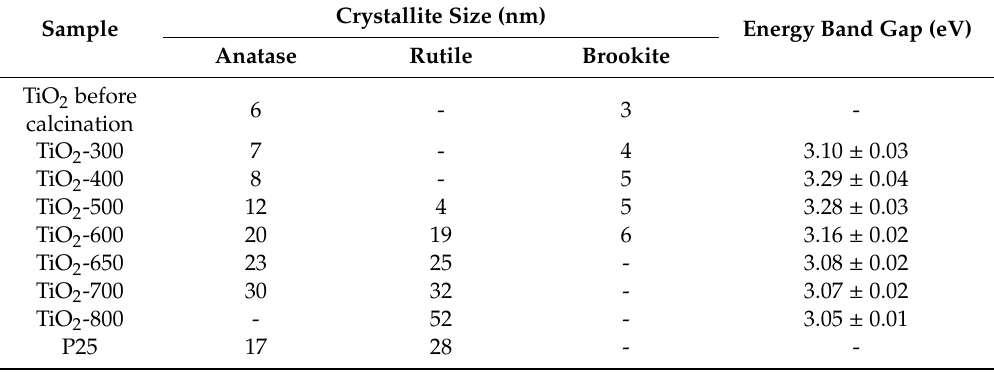
Figure 3. X-ray diffraction (XRD) patterns of TiO 2 particles before and after calcination at different temperatures ranging from 300 °C to 800 °C. Table 1. Crystallite size and energy band gap of synthesized TiO 2 particles before and after calcination and commercial P25 TiO 2 .